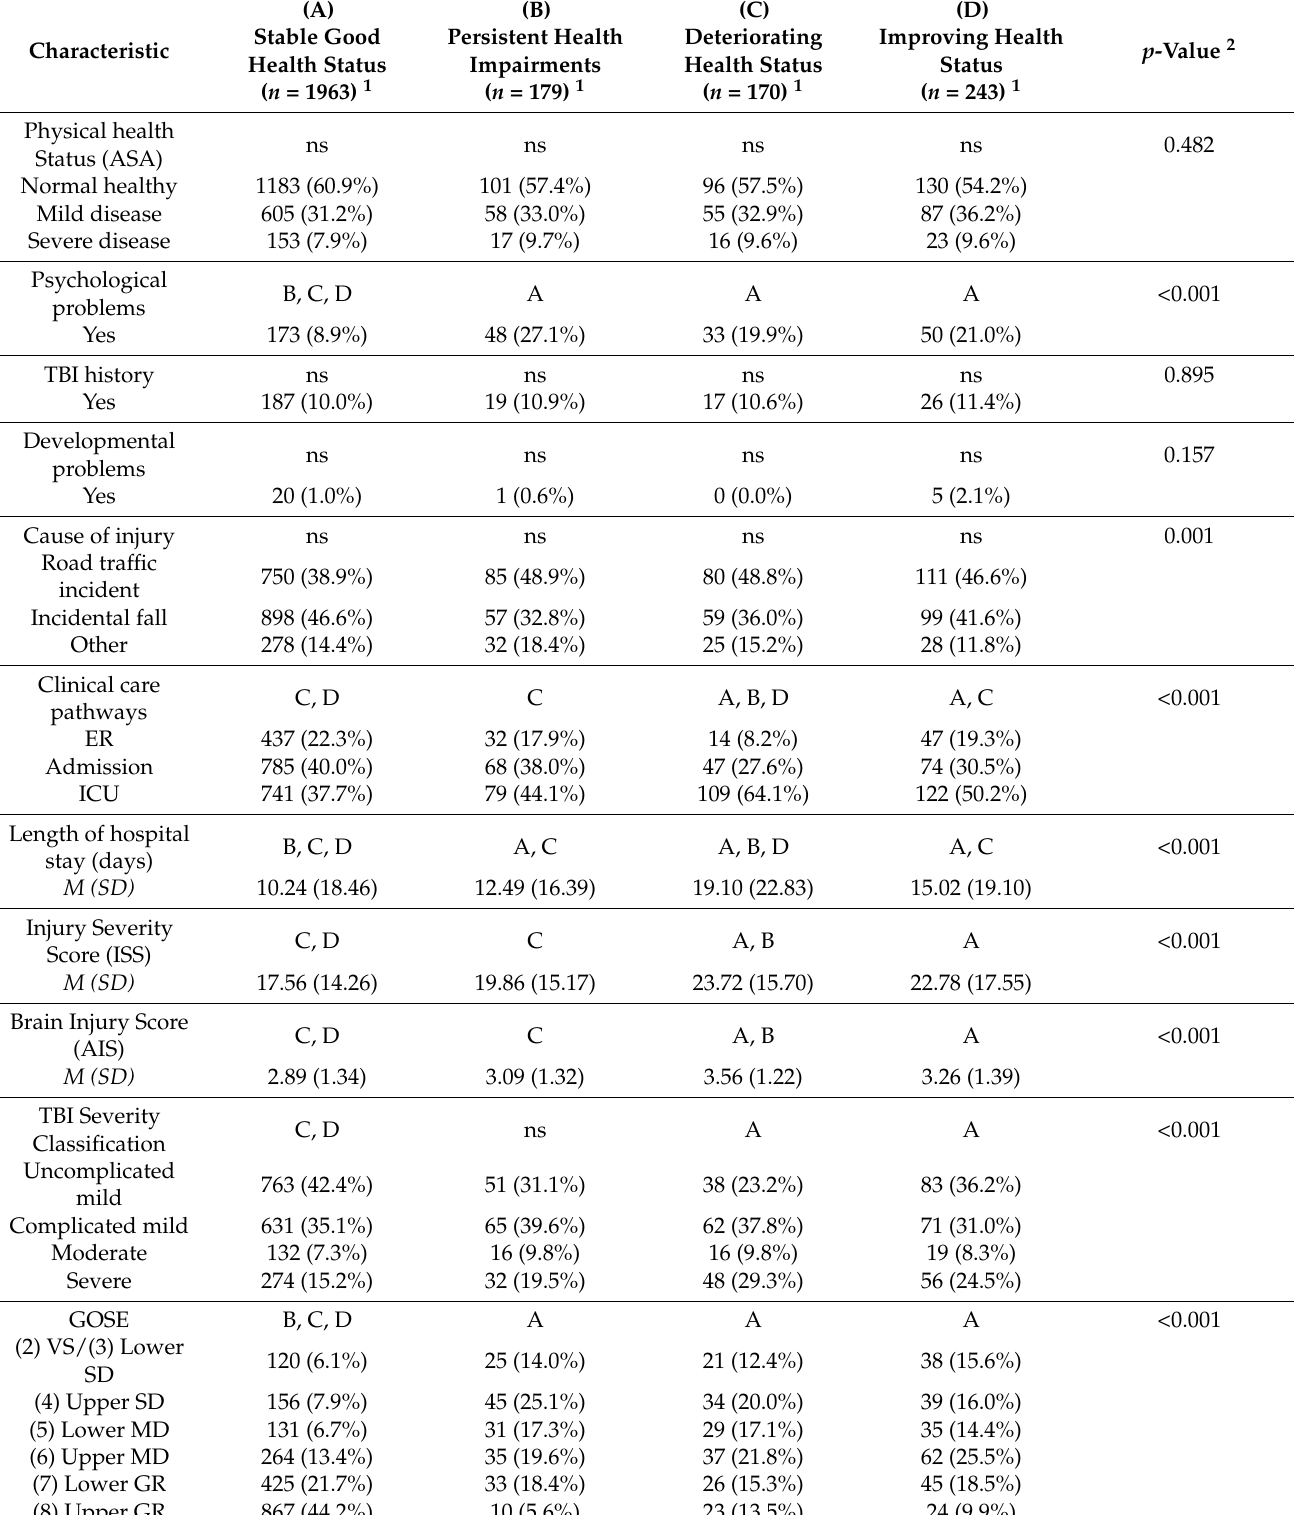
Table A14. Descriptive injury-related statistics for the four classes of symptom